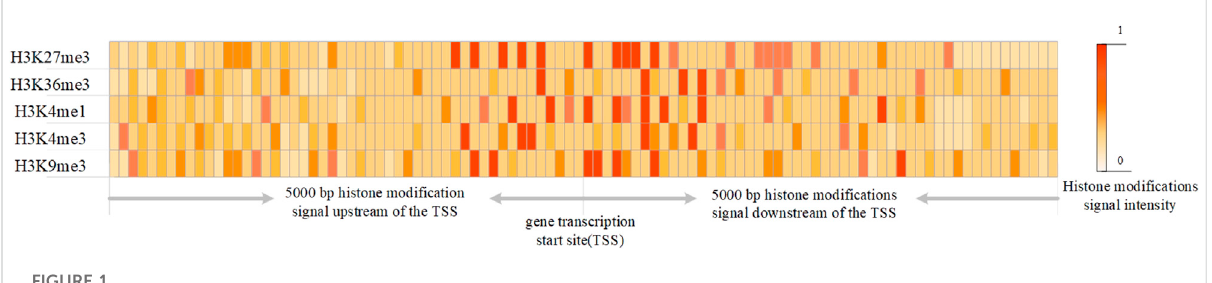
FIGURE 1 The data structure representing histone modi fi cations.